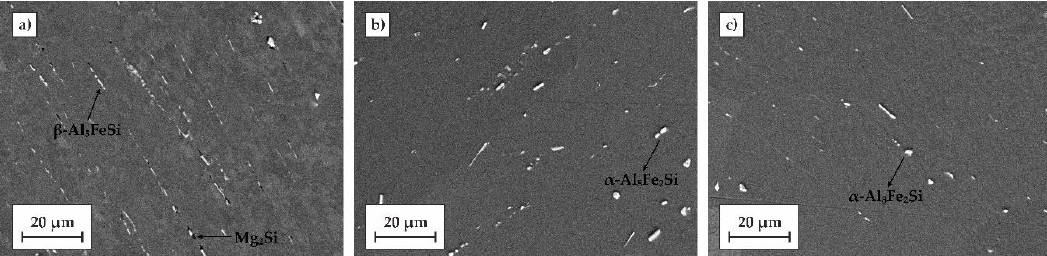
Figure 7. SEM micrographs of longitudinal sections of the wire rod after different heat treatment stages: ( a ) as-fabricated; ( b ) solution heat treated at 530 °C/2 h, water quenched, naturally aged, artificially aged at 170 °C/24 h; ( c ) solution heat treated at 530 °C/2 h, cooled down by flowing air forced to 170 °C, artificially aged at 170 °C/24 h.